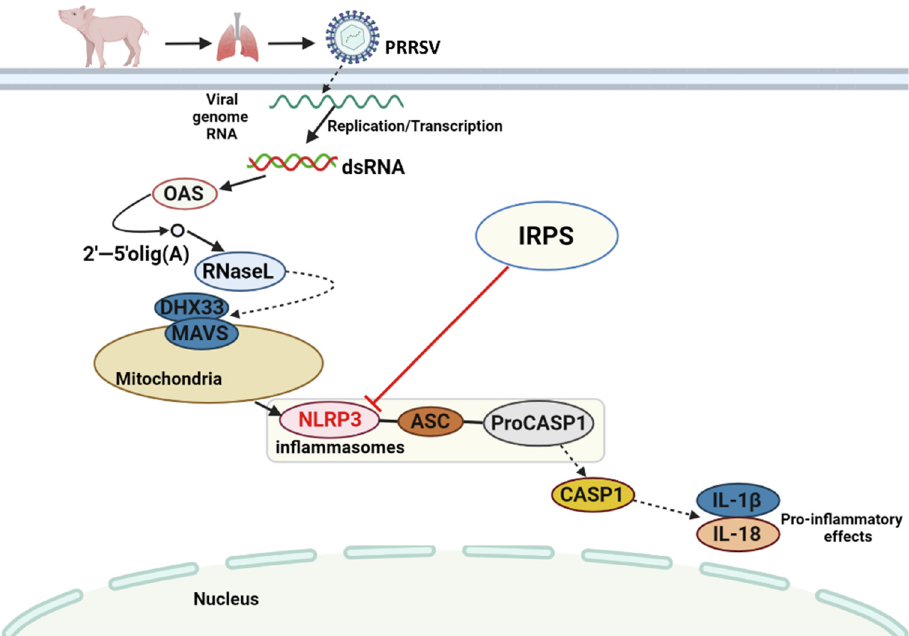
Figure 7. Schematic presentation of the IRPS anti-PRRSV molecular mechanism. The graphic was created with BioRender.com. PRRSV becomes double-stranded RNA (dsRNA) by replication and transcription, and acts directly on OAS gene. OAS gene could promote RNaseL expression. RNaseL acts indirectly on DHX33 and MAVS, which in turn activate inflammasomes (NLRP3, ASC, Pro- CASP1). Then, the inflammasomes act indirectly on CASP1, and finally activates IL-1 and IL-18, thus triggering inflammation in the body. expression; indirect effect;